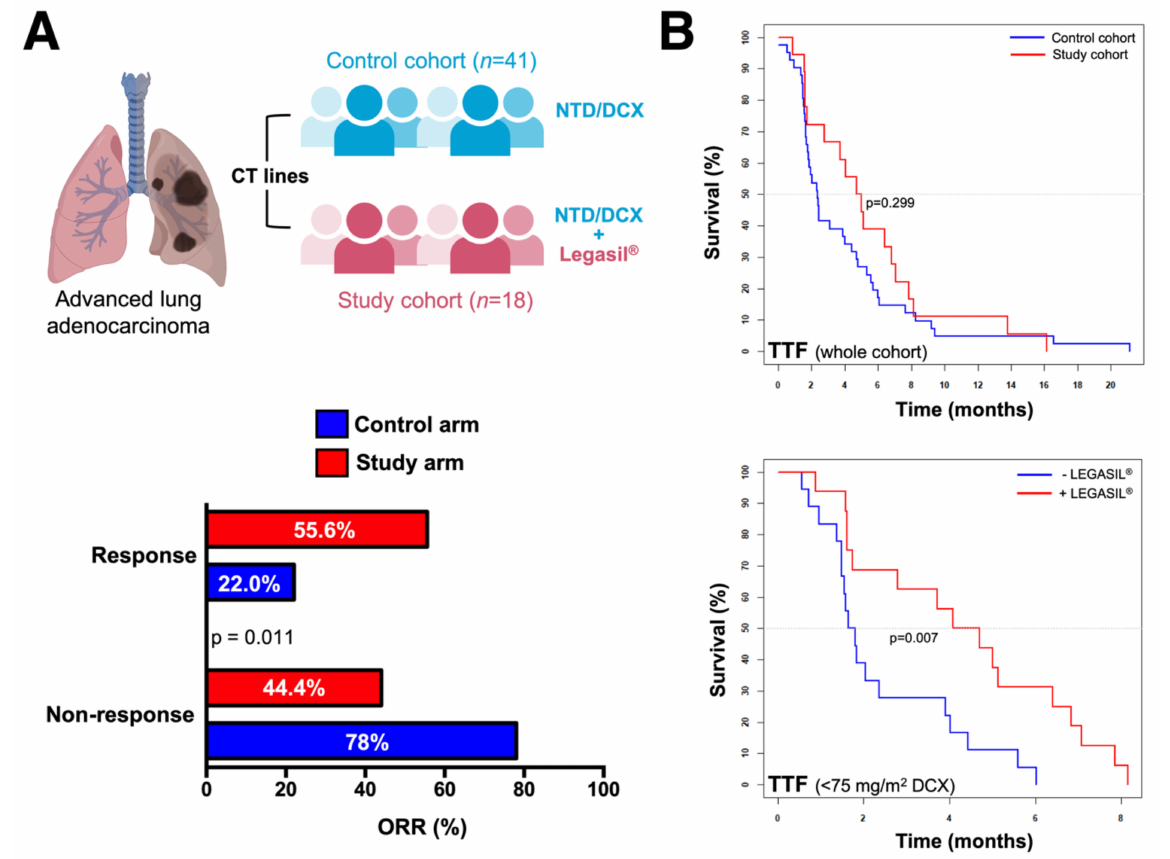
Figure 7. Impact of the silibinin-containing nutraceutical Legasil ® on the clinical efficacy of the nintedanib/docetaxel combination in advanced lung adenocarcinoma. ( A ) Top. We conducted a retrospective, observational multicenter study to assess the efficacy of incorporating the oral nutraceutical product Legasil ® containing silibinin in patients with advanced lung adenocarcinoma receiving nintedanib/docetaxel combination in second- and further-line settings ( n = 59). Bottom. Overall response rate (ORR, in %)—defined as the combined rates of complete and partial responses—in the control and study arms. ( B ) Kaplan–Meier TFF curves of patients stratified by control/study arms ( top ) and ( − ) Legasil ® /(+) Legasil ® co-treatment ( bottom